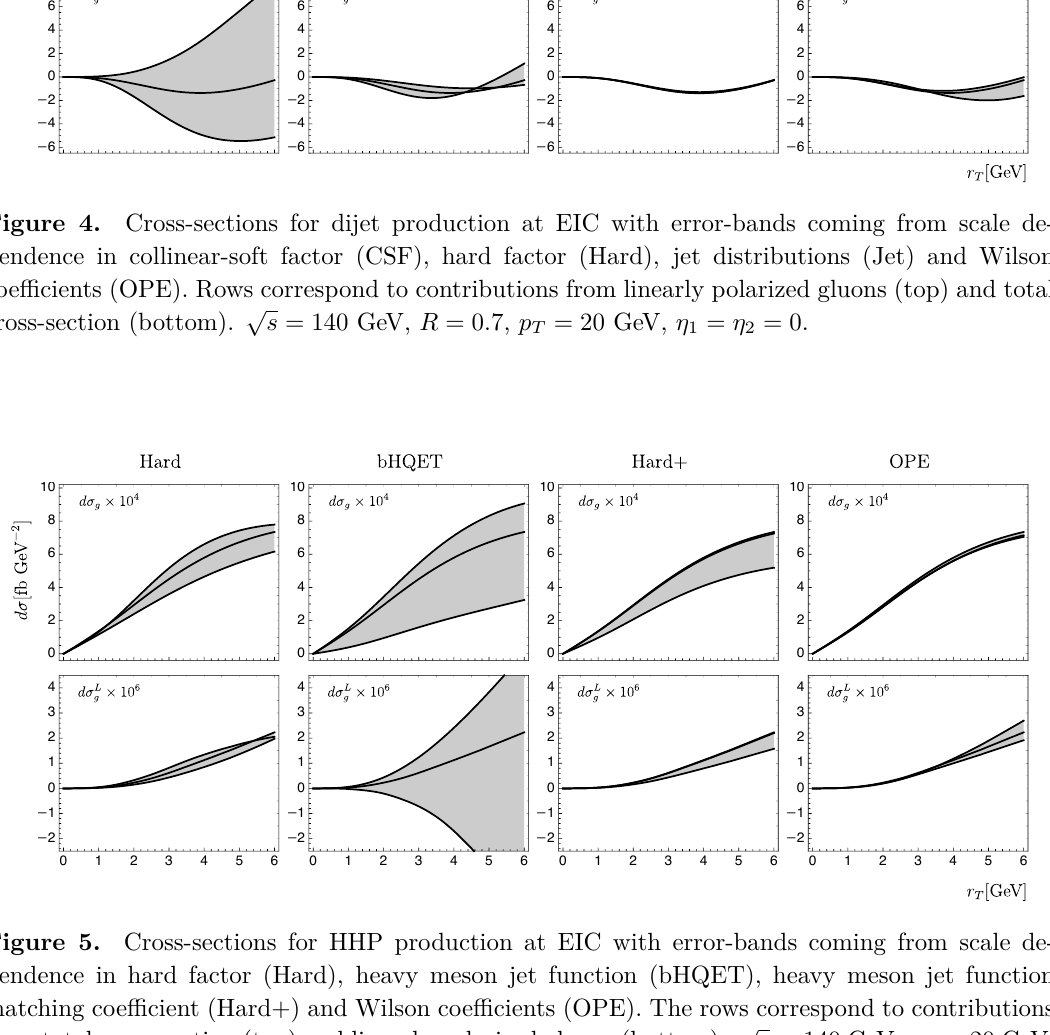
√ s = 140 GeV, p T = 20 GeV,